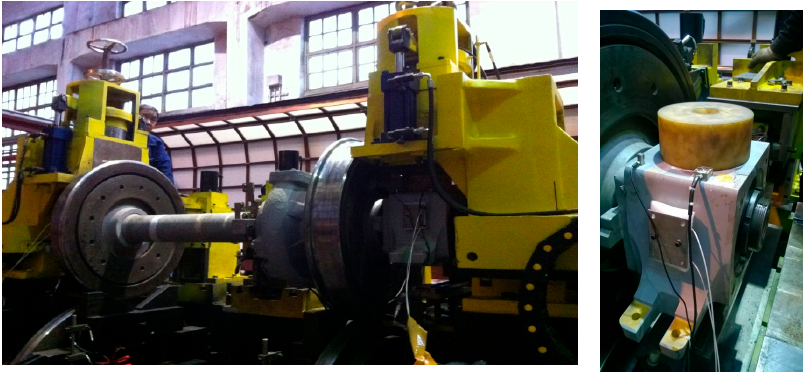
Figure 5. Experimental setup.